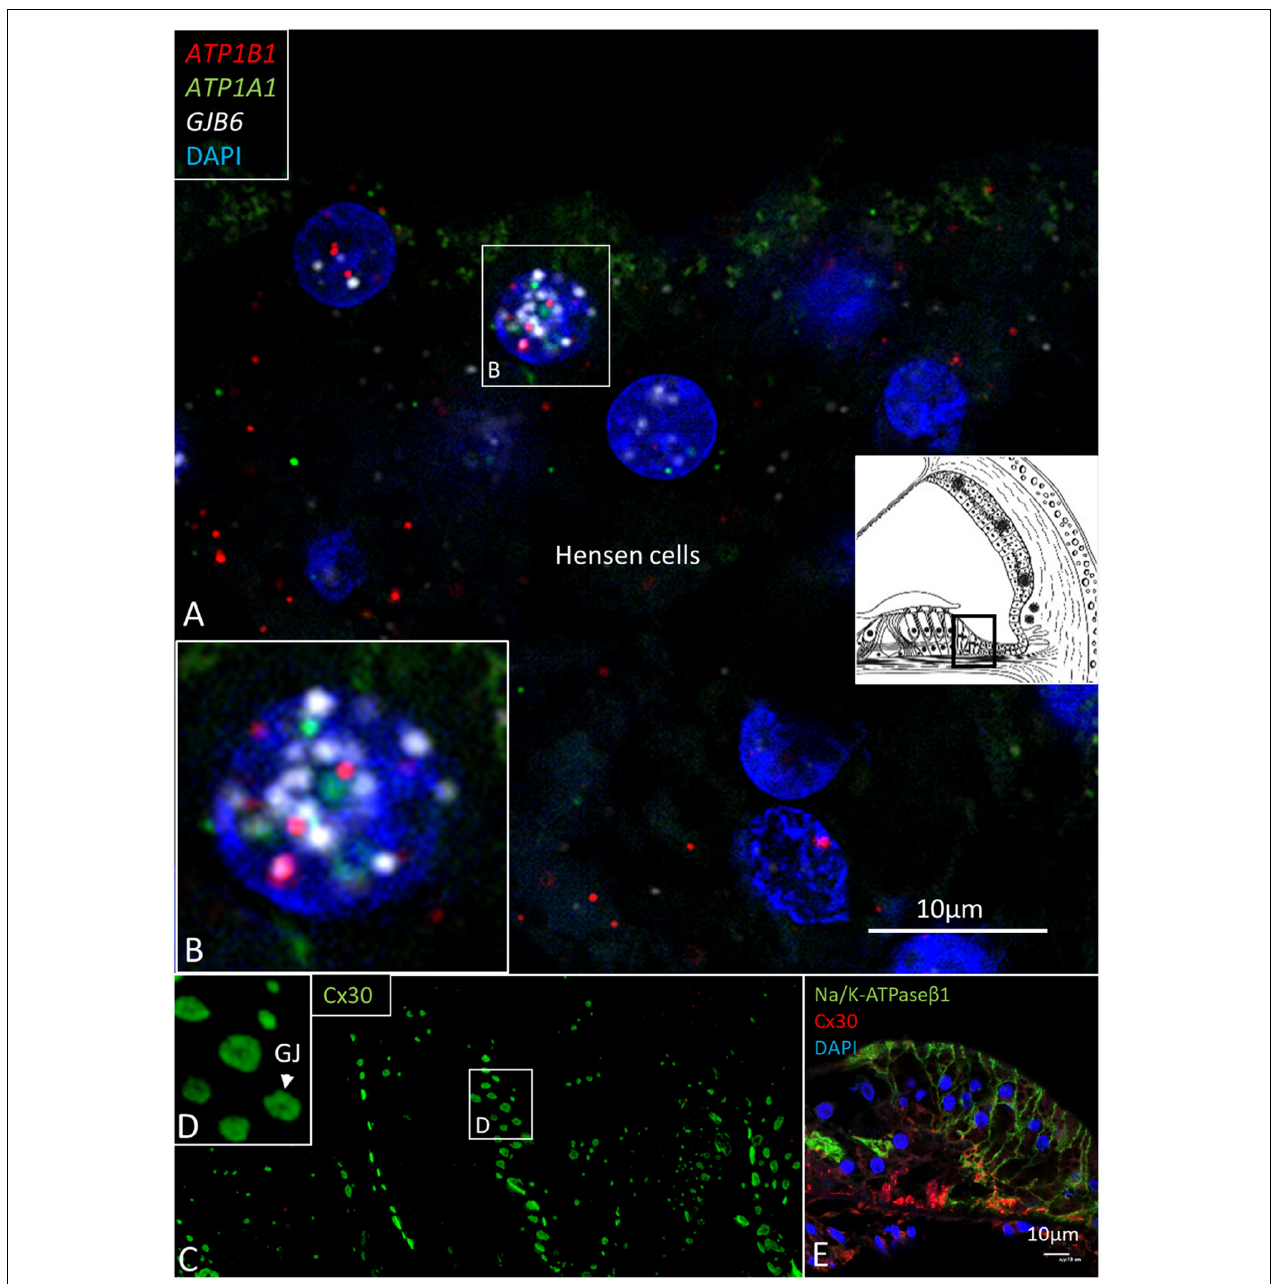
FIGURE 8 | (A) Multiplex RNAscope R (cid:13) ISH and SR-SIM of the Hensen cell region. Cell nuclei contain many ATP1A1 , ATP1B1 , and GJB6 gene transcripts. Framed area is magnified in (B) . (B) The 1cell nucleus contains all three transcripts, suggesting active transcription of NKA and Cx30. (C) SR-SIM of Cx30-positive GJ plaques (green) are seen between Hensen cells. (D) Framed area in (C) is magnified. (E) Confocal microscopy showed expression of NKA β 1 in the lateral cell membranes of Hensen cells. Cx30 was also